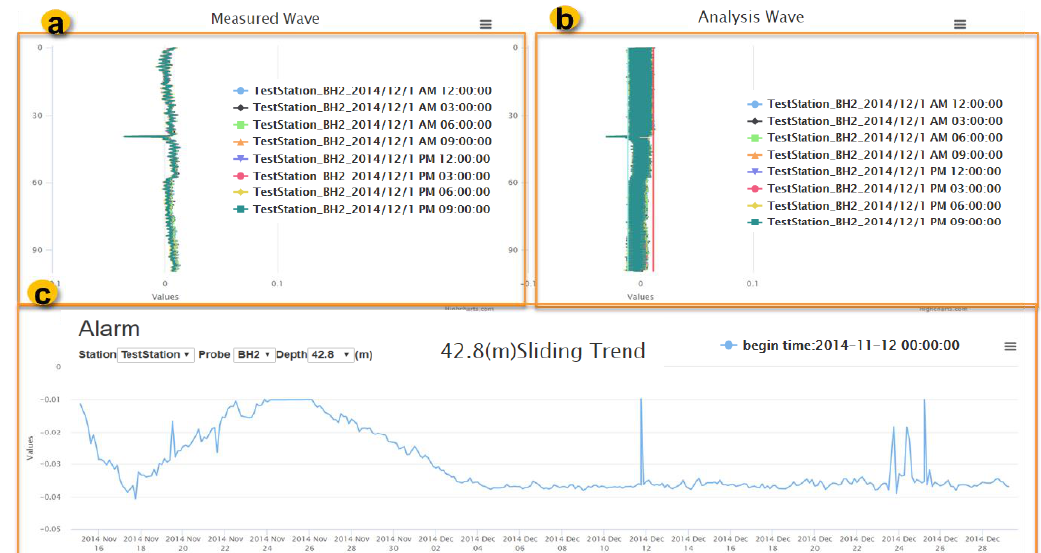
Figure 19. TDR crimp type monitoring setting for reference waveform and effective range.